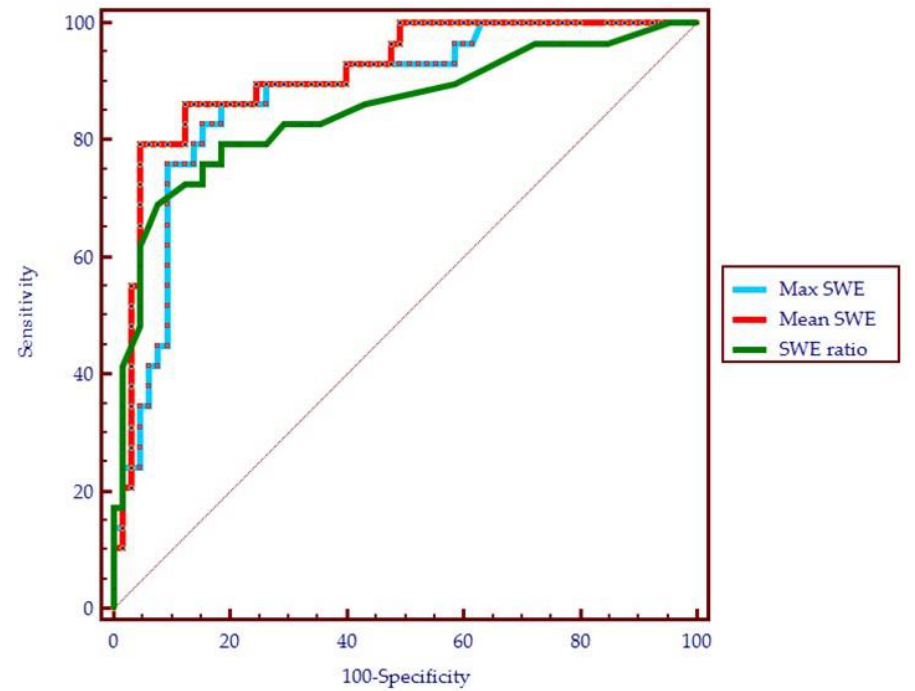
Figure 3. The performance of shear-wave parameters in the diagnosis of thyroid cancer (receiver operating characteristic curve): the maximum elasticity index (Max SWE), mean elasticity index (Mean SWE) and the QBox ratio (SWE ratio).